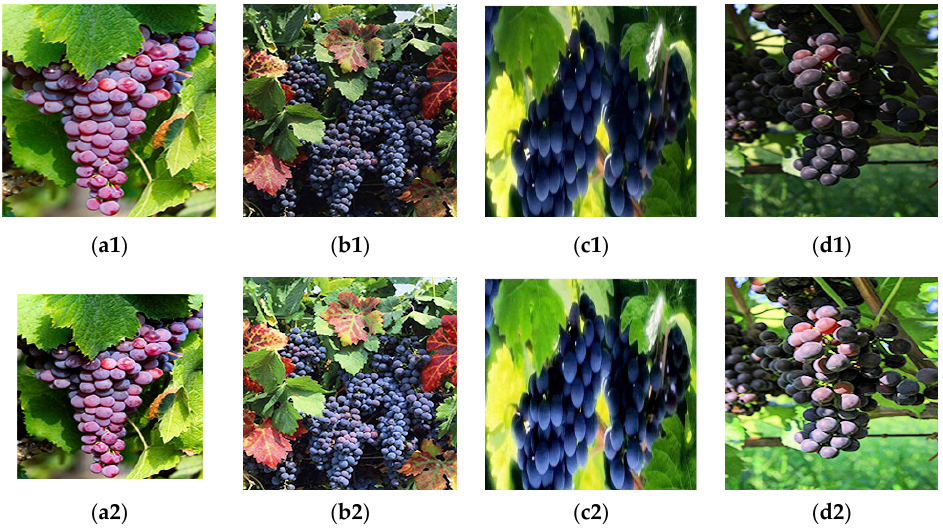
Figure 6. Raw and enhanced images (( a 1– d 1) are the raw images and ( a 2– d 2) are the enhanced